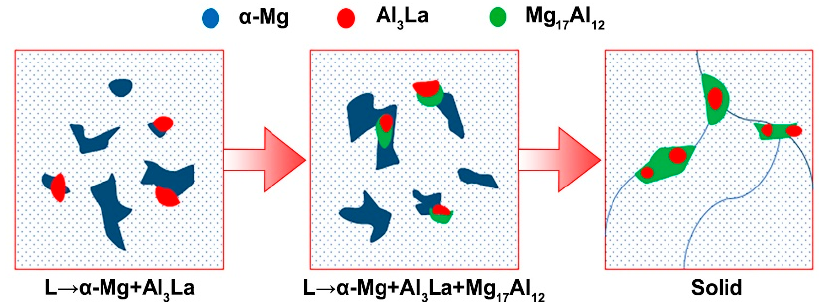
Figure 6. The schematic diagram of AZ91-La alloys’ solidification process.